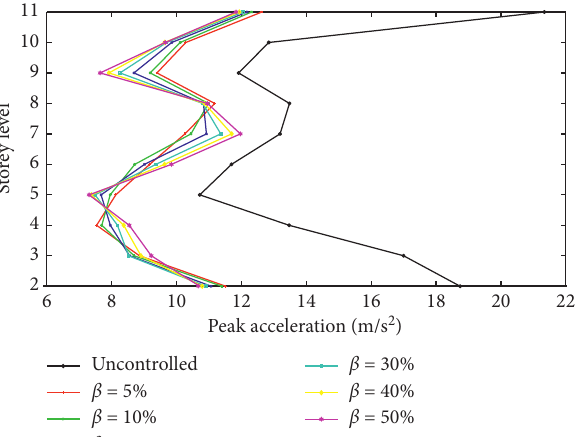
Figure 11: Peak acceleration of each storey of the controlled structure subjected to “Kobe” acceleration record for TMDI designed with µ � 5% and the J P optimization alternative.